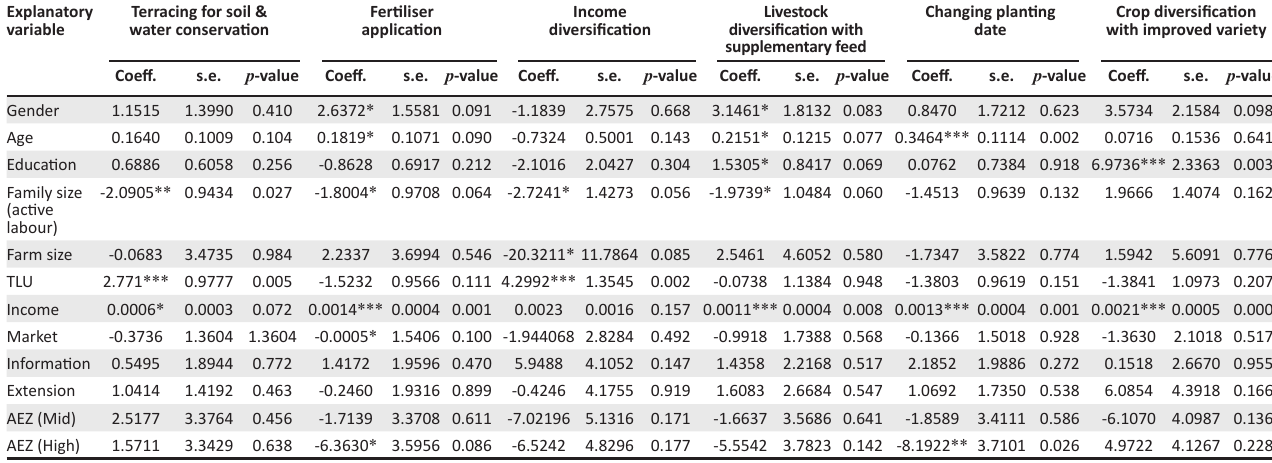
TABLE 2: Estimated parameter estimates of multinomial logit climate change adaptation model. Explanatory